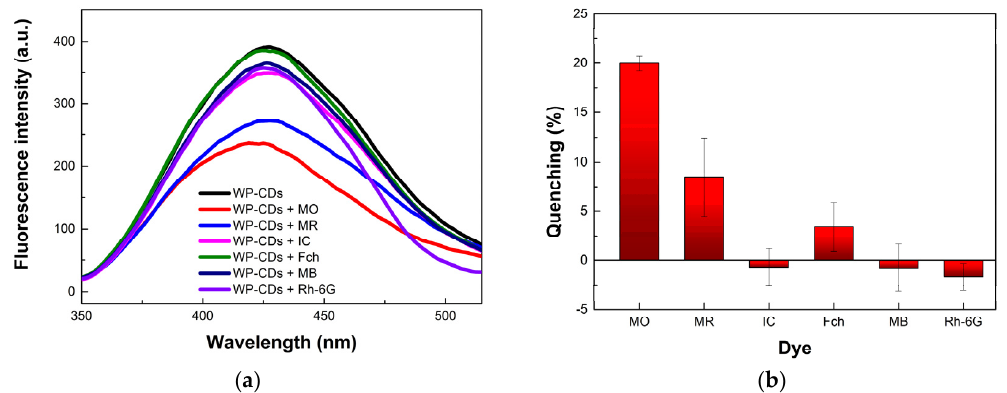
Figure 2. ( a ) Emission spectra of WP-CDs in phosphate buffer (pH = 7.2) in the absence and upon addition of the dyes (10 μ M). Excitation at 340 nm. ( b ) Extent of quenching of WP-CDs’ PL after contact with the dyes, corrected for inner filter effects at excitation (340 nm) and emission (426 nm) wavelengths.